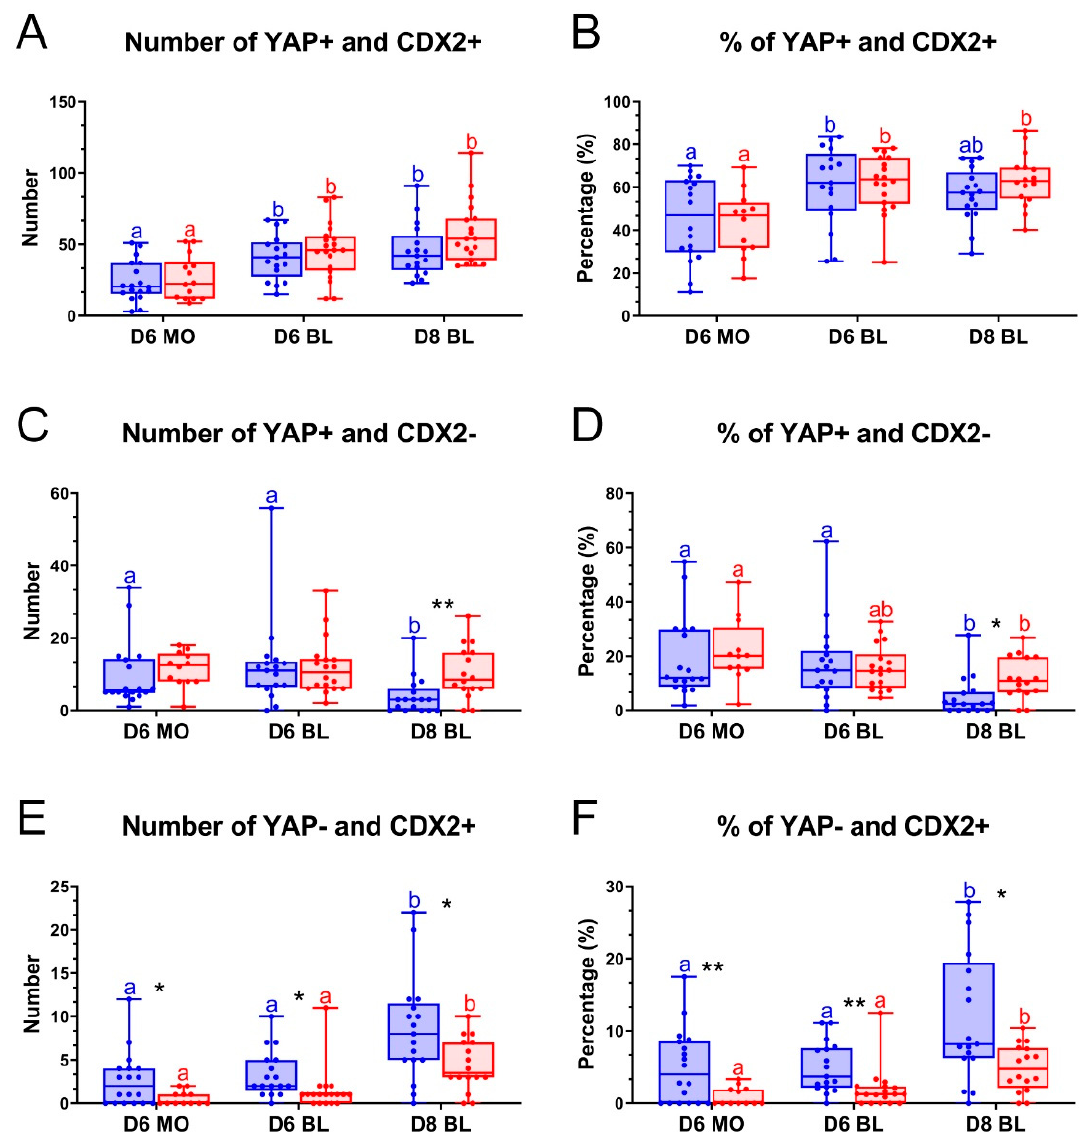
Figure 5. Effect of LPA on YAP and CDX2 localization in bovine embryos. Embryos were cultured in the absence of LPA (blue) or in the presence of 10 − 5 M LPA (red). Number of cells with colocalized YAP and CDX2 ( A ), percentage of YAP and CDX2 colocalization out of total cells ( B ), number of YAP positive (YAP+) but CDX2 negative (CDX2-) cells ( C ), percentage of YAP positive but CDX2 negative cells ( D ), number of YAP negative (YAP-) but CDX2 positive (CDX2+) cells ( E ), percentage of YAP negative but CDX2 positive cells ( F ). * ( p < 0.05) and ** ( p < 0.01) indicate significant differences between embryos cultured with and without LPA. Significant differences among embryos cultured under the same conditions are indicated by different letters with the same color ( p < 0.05). Error bars indicate standard deviations for embryos, collected from three biological replicates. D = day, MO = morula, BL = blastocyst.